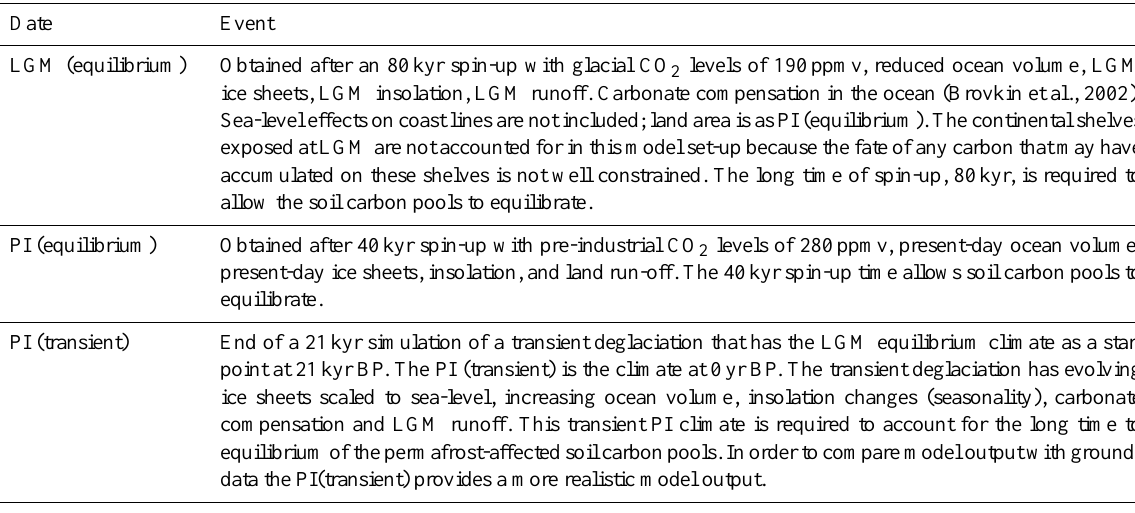
Table 1. Simulated climates used in this study.